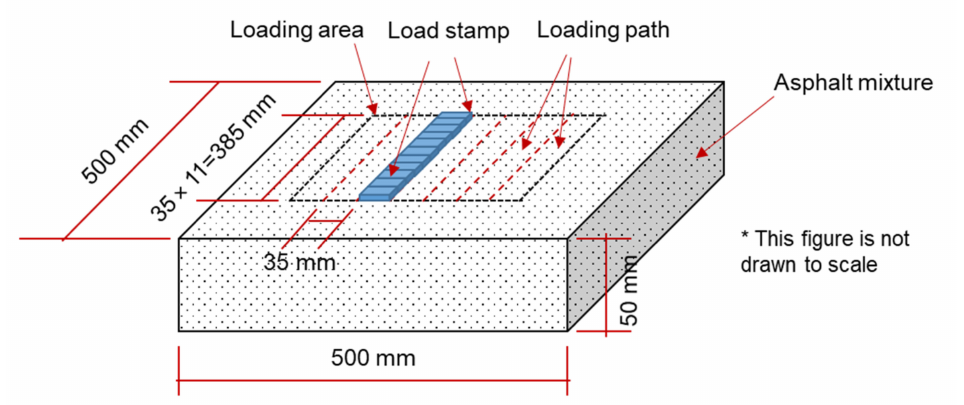
Figure 12. Geometry of asphalt mixture